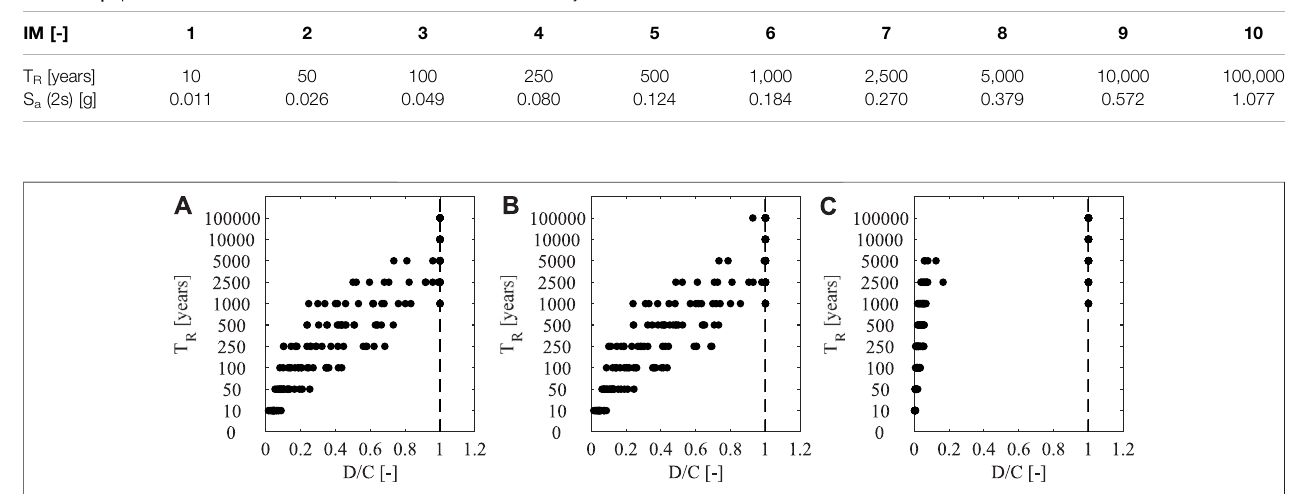
TABLE 2 | Spectral acceleration values for each selected seismic intensity level.